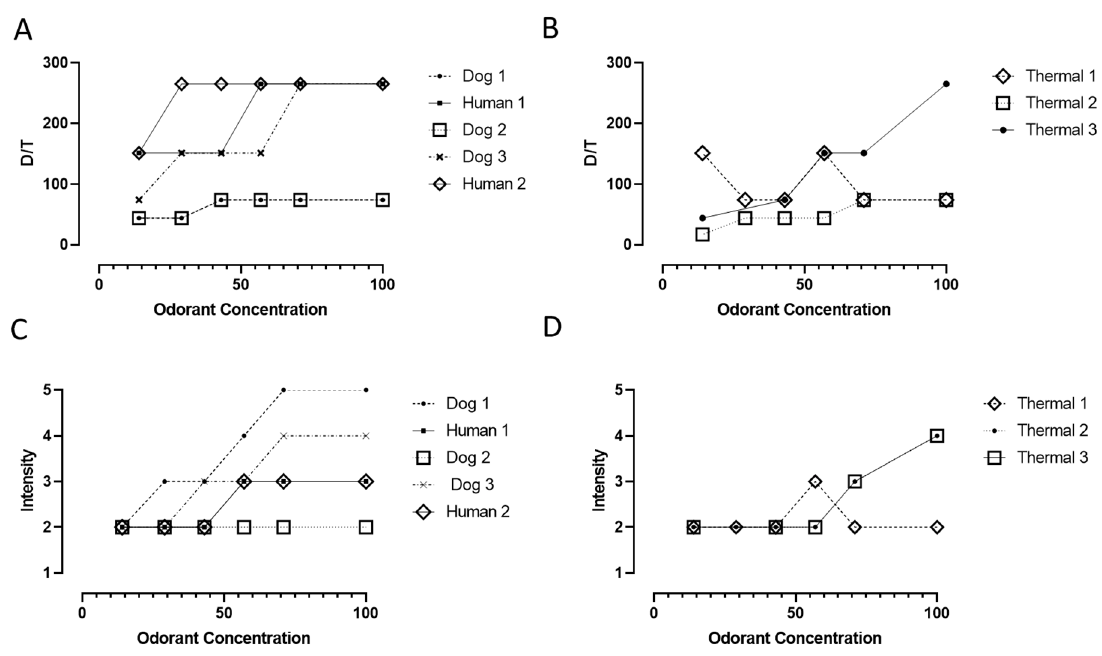
Figure 3. Dilution to threshold (D / T) ( A and B panels) and odor intensity ( C and D panels) of fecal odor samples tested with the low-cost sensors as a function of their concentration with respect to the original odor sample (i.e., 100% is undiluted). See the Methods section for details.